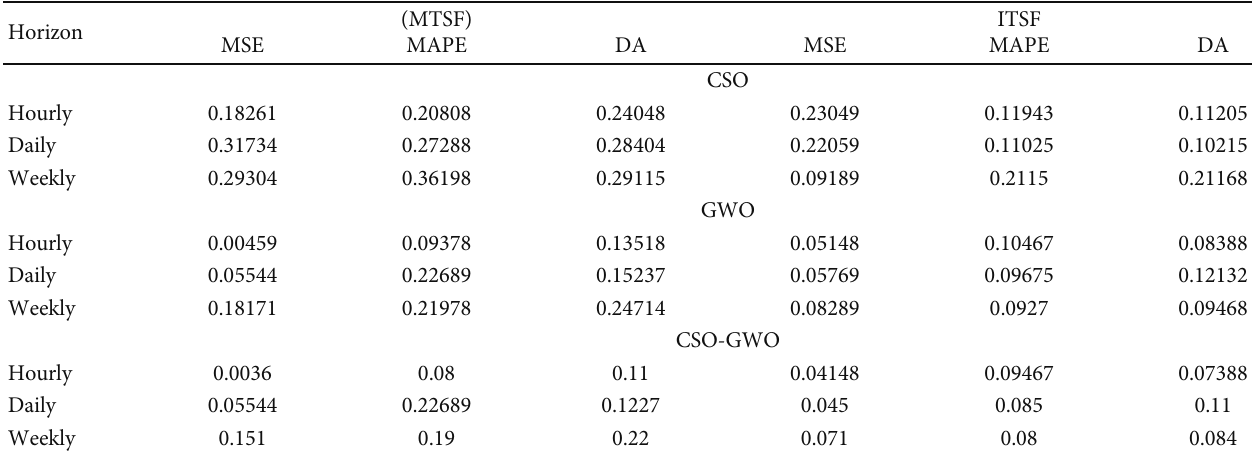
Table 1: Performance metrics of MTSF and ITSF.